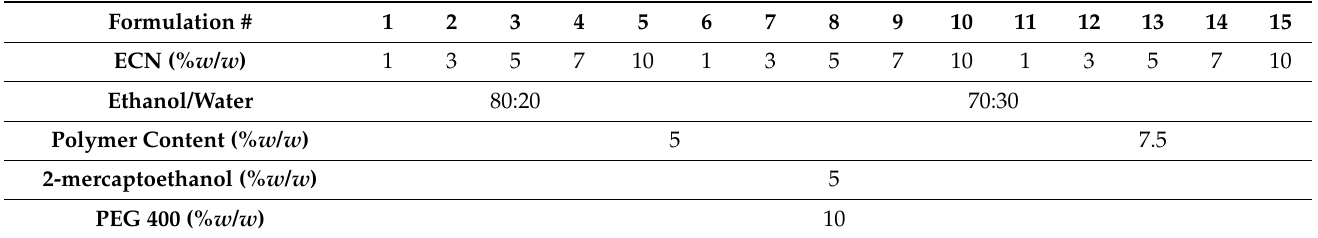
Table 1. Preliminary lacquer formulations showing different combinations of the excipients.